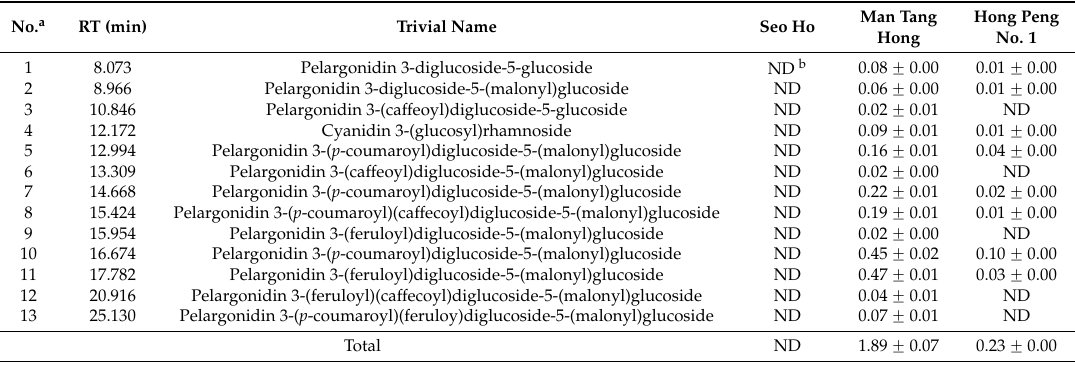
Table 1. Anthocyanin content (mg/g dry wt.) in red